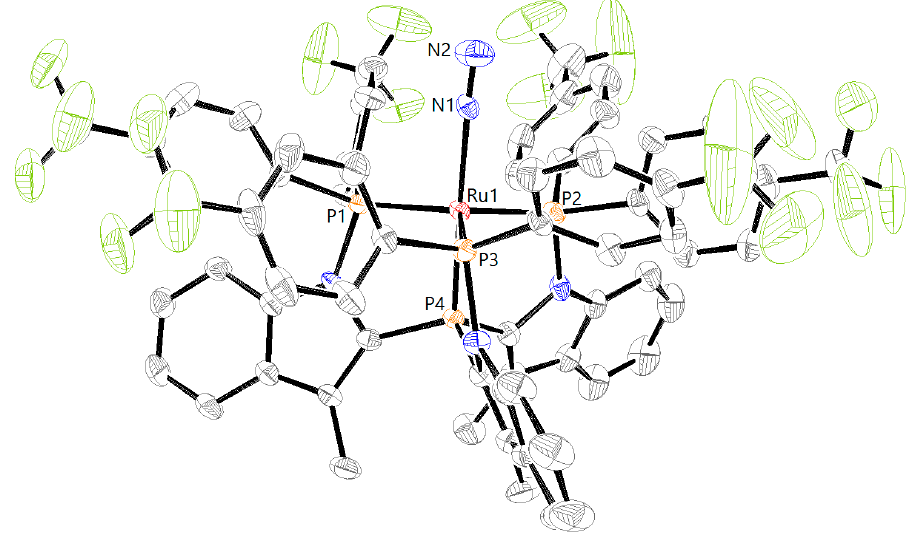
Figure 10. ORTEP drawing of RuN 2 L1 CF3 (top, CCDC 1574142) showing one of the two rotamers. Thermal ellipsoids are set at 50% probability. Solvent molecules and hydrogen atoms have been omitted for clarity.